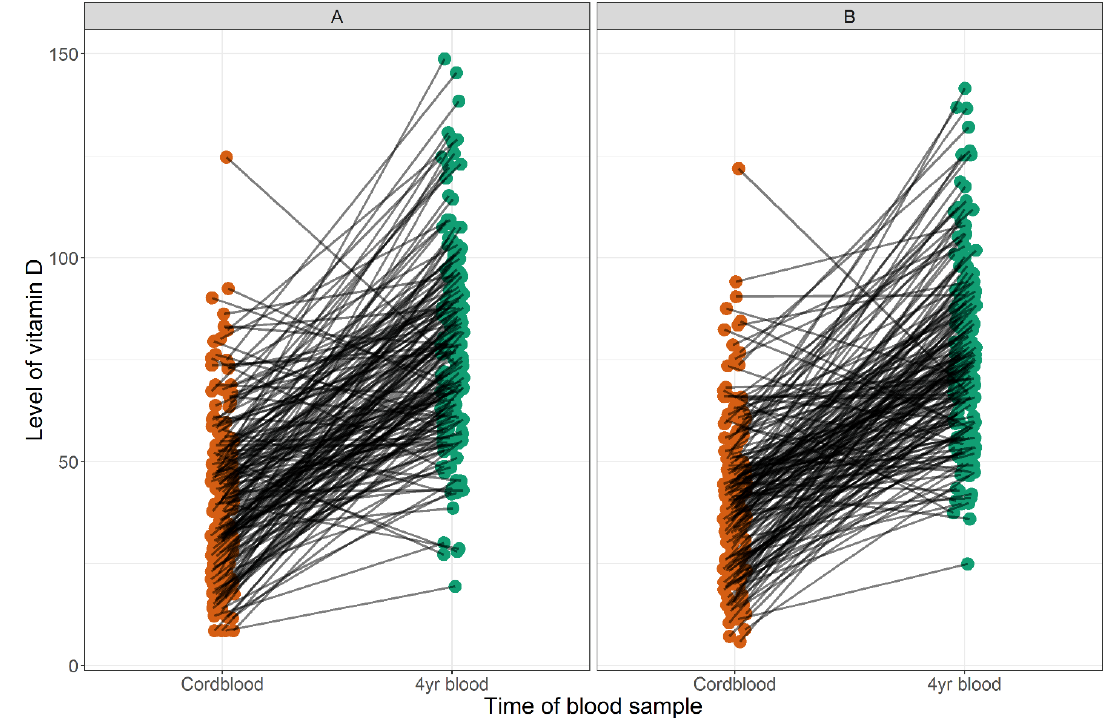
Figure 4. Correlation between cord blood and age 4 years 25(OH)D level in nmol / L unadjusted ( A ) and adjusted for season of blood sampling ( B ).